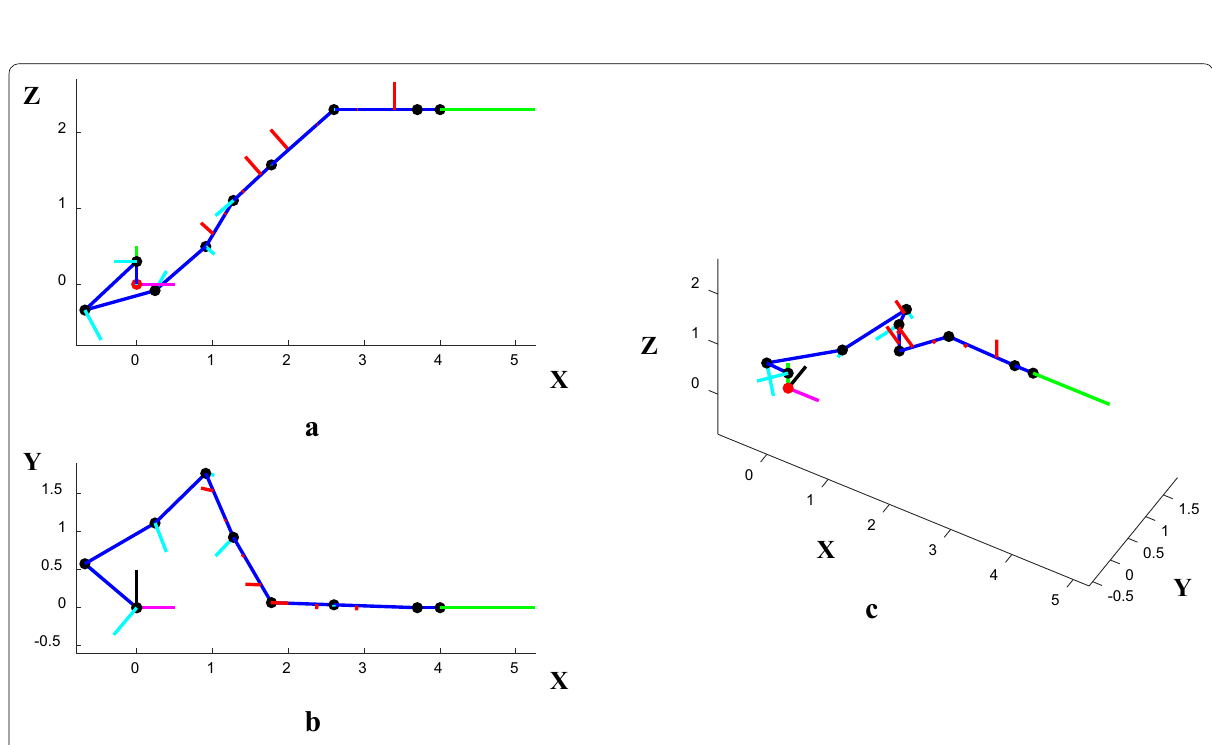
Fig. 8 The simulation arm and flying watch thrusts under the first level watch-actuator cooperation when the external reaction force on the end effector is [125,0,0] N (reduction rate 24.1%). a Front view. b Top view. c 3-D view =